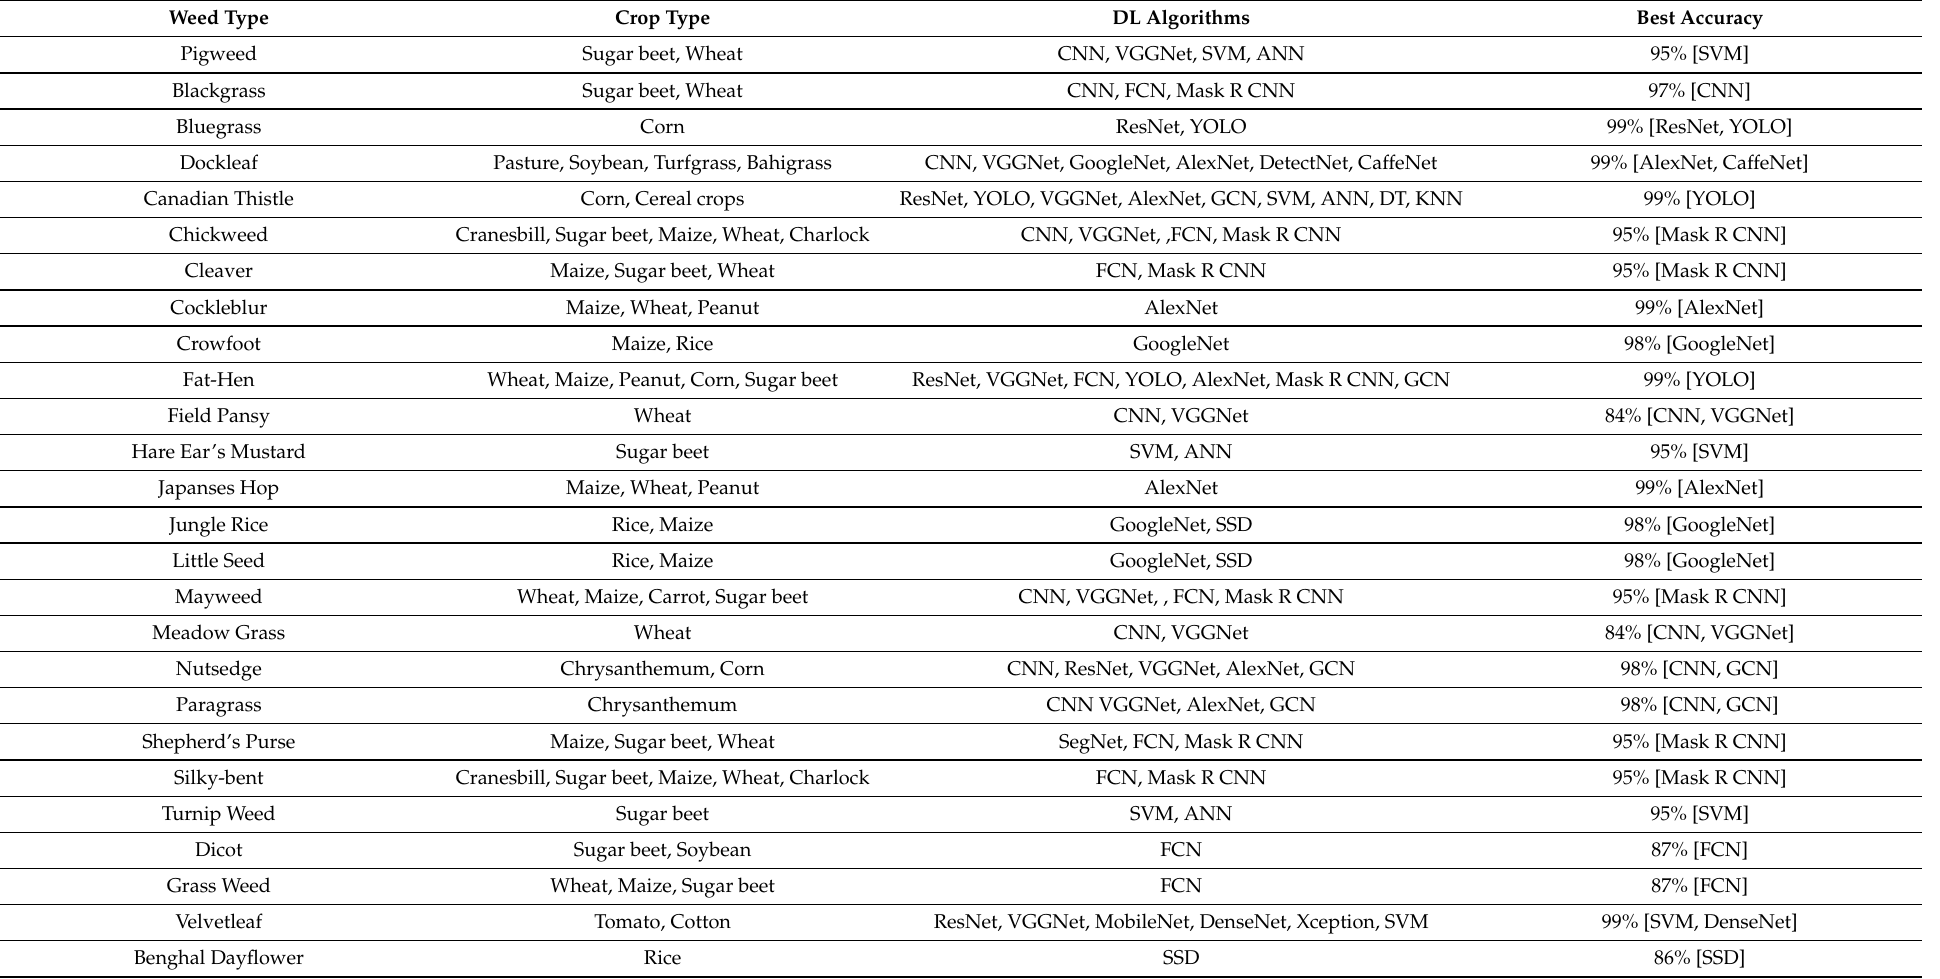
Table 7. Classification of Weeds and Crops wrt